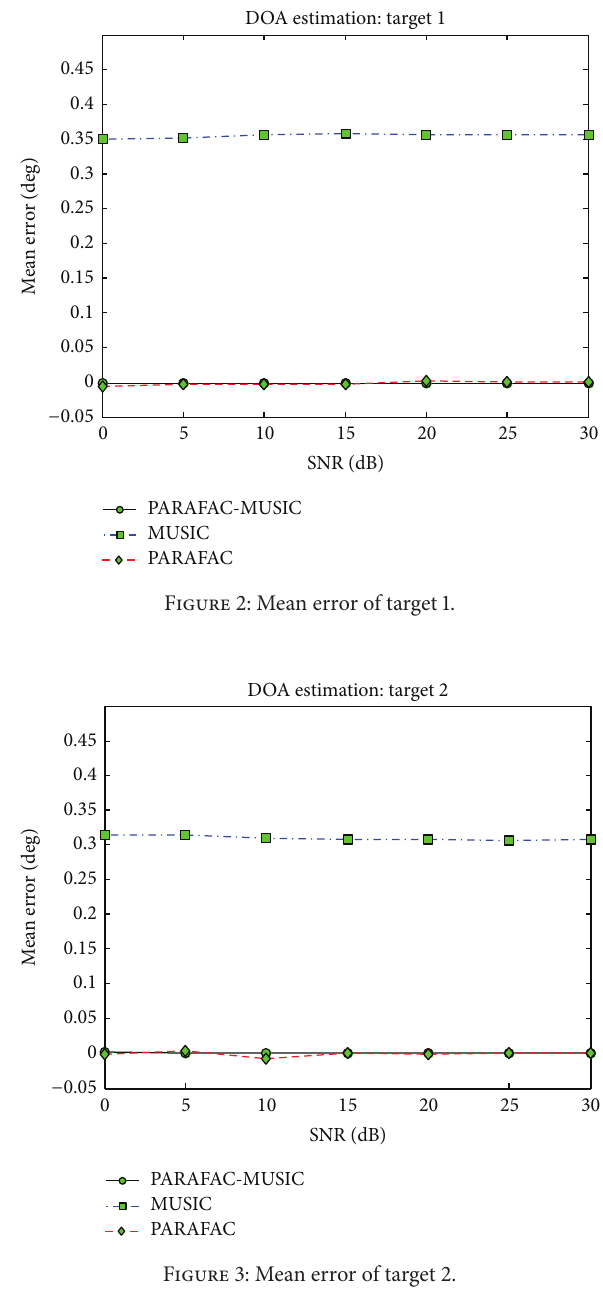
Figure 3: Mean error of target